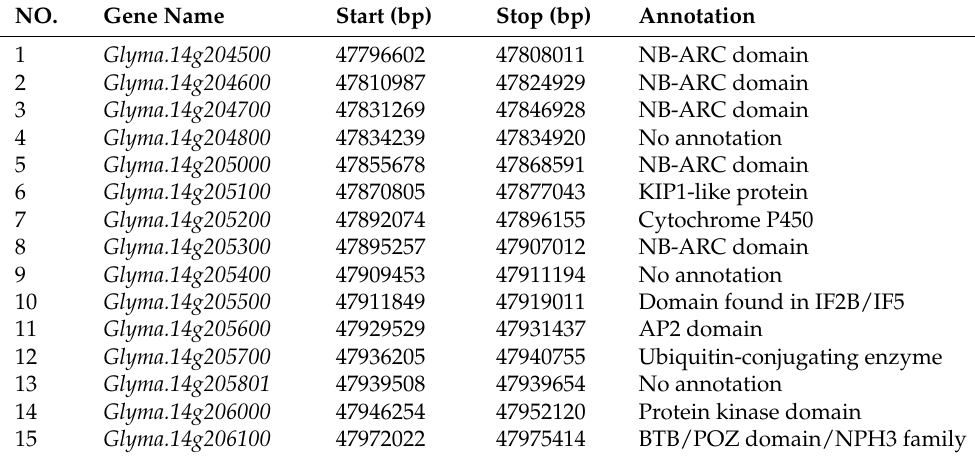
Table 2. Functional annotation of candidate genes in the spwp1 mapping interval.